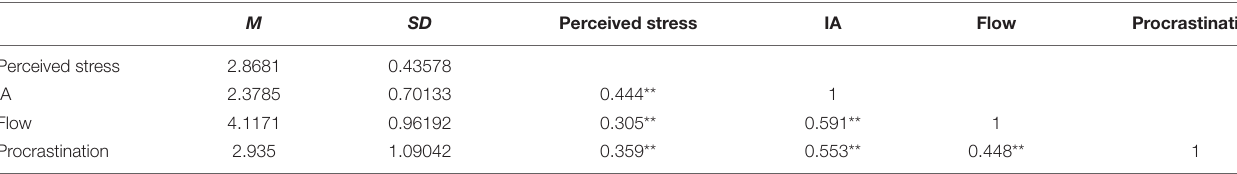
TABLE 1 | The Results of descriptive statistics and correlation analysis. M